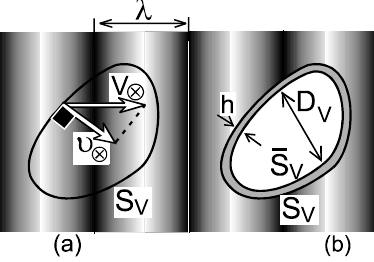
Figure 4. Matching of distribution of normal oscillatory velocities (DNOV) to obtain a "transparent" body ( λ -